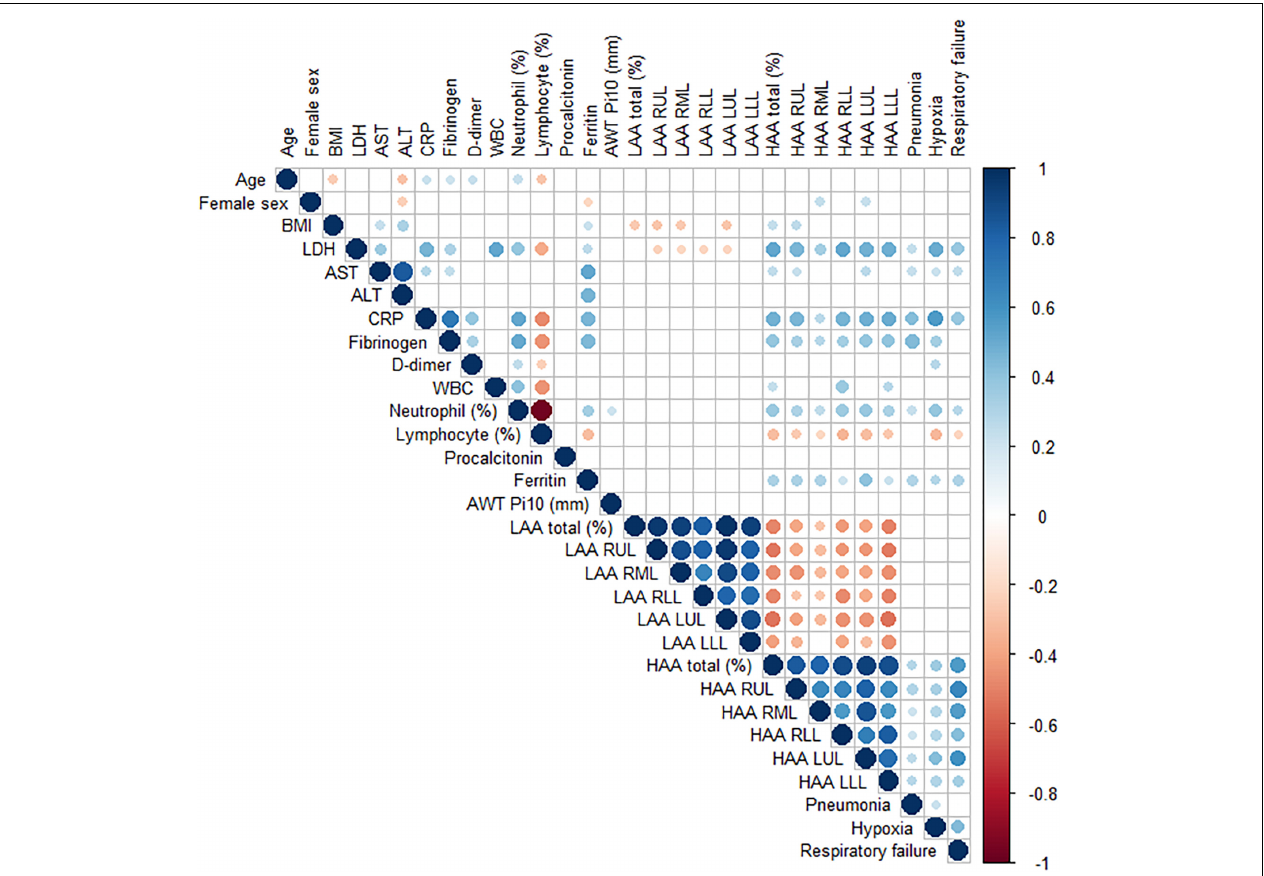
FIGURE 2 | A correlation matrix of demographic, laboratory and quantitative CT image findings. Pearson correlation between variables was performed. The circle sizes and intensity of colors correlate with the strength of their association. The blue and red color indicate positive and negative correlation, respectively. Only statistically significant associations are drawn. Abbreviation: BMI, body mass index; LDH, lactate dehydrogenase; AST, aspartate aminotransferase; ALT, alanine aminotransferase; CRP, C-reactive protein; WBC; white blood cell; LAA, low attenuation area; RUL, right upper lobe; RML, right middle lobe; RLL, right lower lobe; LUL, left upper lobe, LLL; left lower lobe; HAA, high attenuation area.